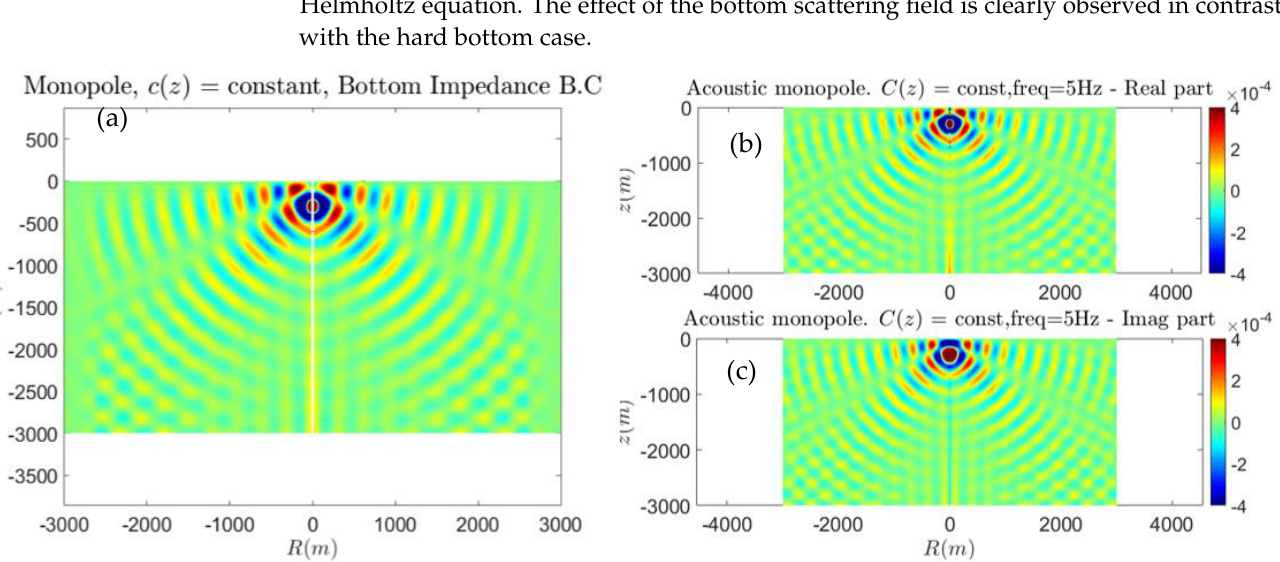
Figure 15. ( a ) The acoustic field obtained using the solution of the FDTD–PML numerical scheme excited by a monopole source of frequency f = 5 Hz located at a depth of 300 m with an impedance bottom boundary condition in the isovelocity environment. ( b , c ) Real and imaginary parts of the acoustic field obtained using the solution of the Helmholtz equation excited by a monopole source of frequency f = 5 Hz located at a depth of 300 m with an impedance boundary condition.